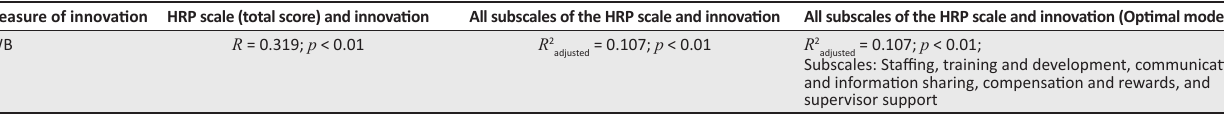
HRP, human resource practices; IWB, innovative work behaviour. TABLE 3: Organisation specific correlation and regression analyses ( N = 60 per organisation). Organisation Measure of HRP scale (total score) innovation and innovation